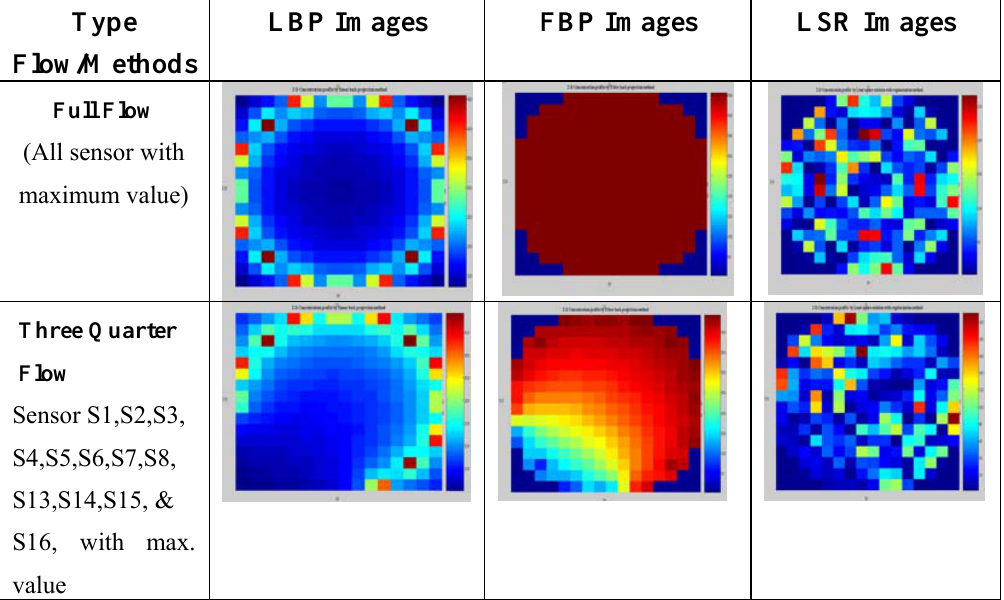
Figure 11. Simulation images for different types of flow pattern using LBP, FBP and LSR